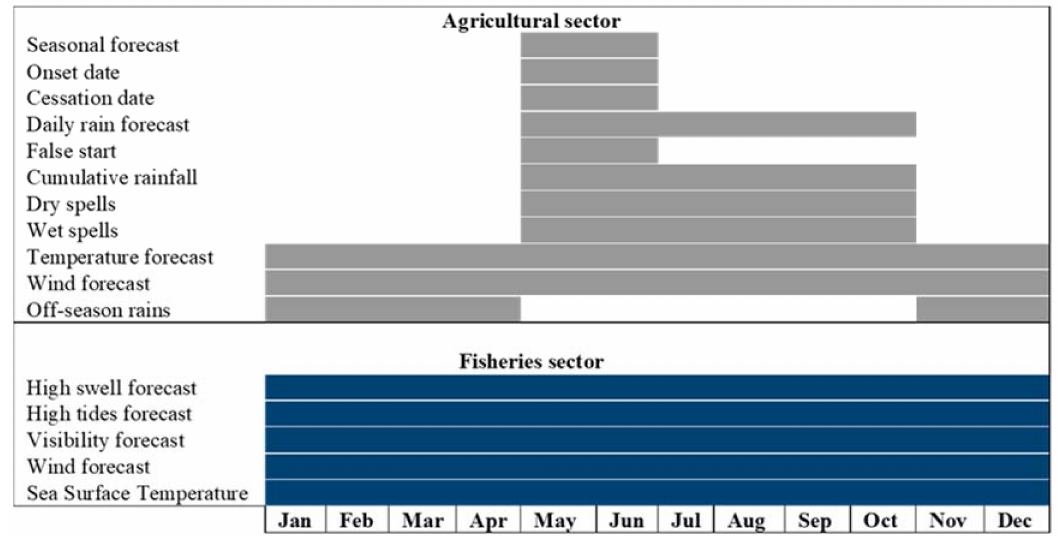
Figure 2. Diffusion timing for produced CIS (source: from